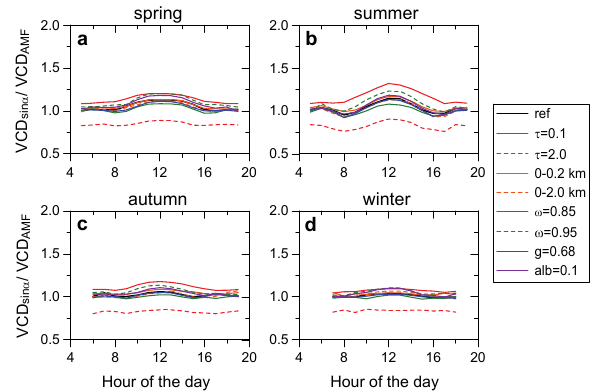
Fig. 5. Same as Fig. 4, but for the 45 ◦ elevation angle. swath on the Earth’s surface for one orbit, large enough to achieve complete global coverage in one day. Its spatial res- olution is 24 × 13 km 2 in nadir, and increases to 68 × 14 km 2 at the swath edges (discarding the outer 5 pixels). Compared to SCIAMACHY, OMI has a better spatial resolution and by far more measurements. In this study, OMI NO 2 tropo- spheric VCDs from TEMIS (Tropospheric Emission Mon- itoring Internet Service, at http://www.temis.nl), developed within the project “Derivation of Ozone Monitoring Instru- ment tropospheric NO 2 in near-real time” (DOMINO), are used (DOMINO versions 1.02 and 2.0). For the DOMINO retrievals, the stratospheric NO 2 column is assimilated by the TM4 chemical transport model. Tropospheric AMFs are cal- culated based on tropospheric a priori profiles of NO 2 from TM4. In version DOMINO v2.0, some improvements (radia- tive transfer calculations, a priori terrain heights and surface albedo, and the TM4 sampling) have been introduced to this last step. For details see Boersma et al. (2007,